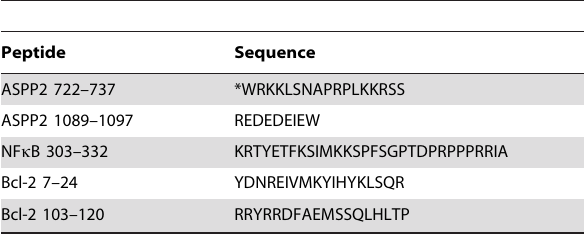
Table 1. The ASPP2 Ank-SH3 binding peptides used in this